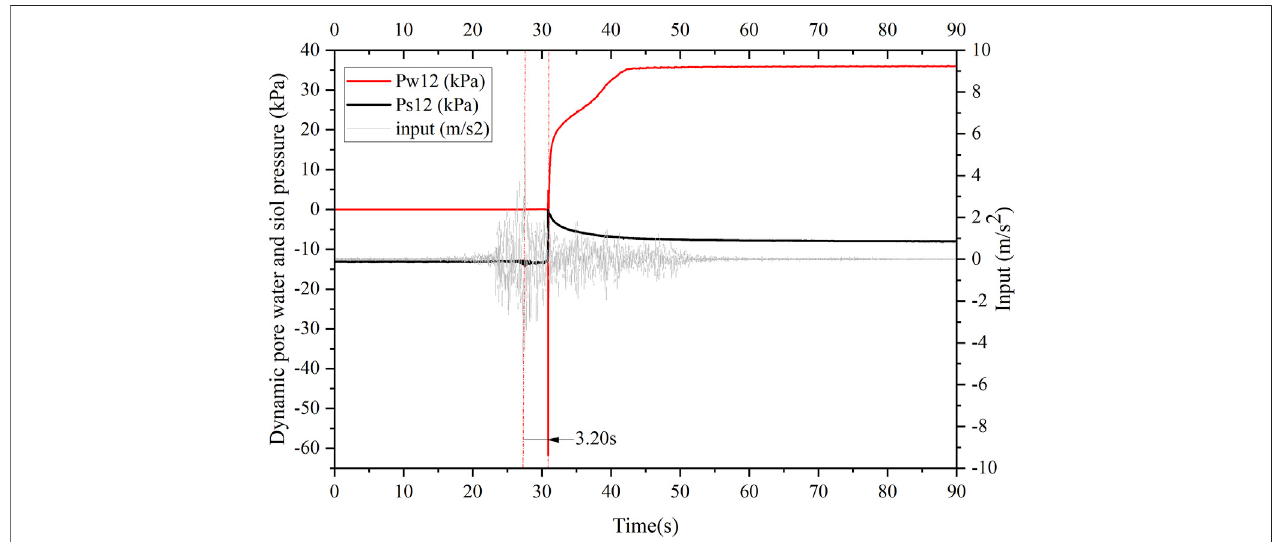
FIGURE 13 | Dynamic pore water pressure and soil pressure of P w 12 and Ps12 in the lique fi ed zone.